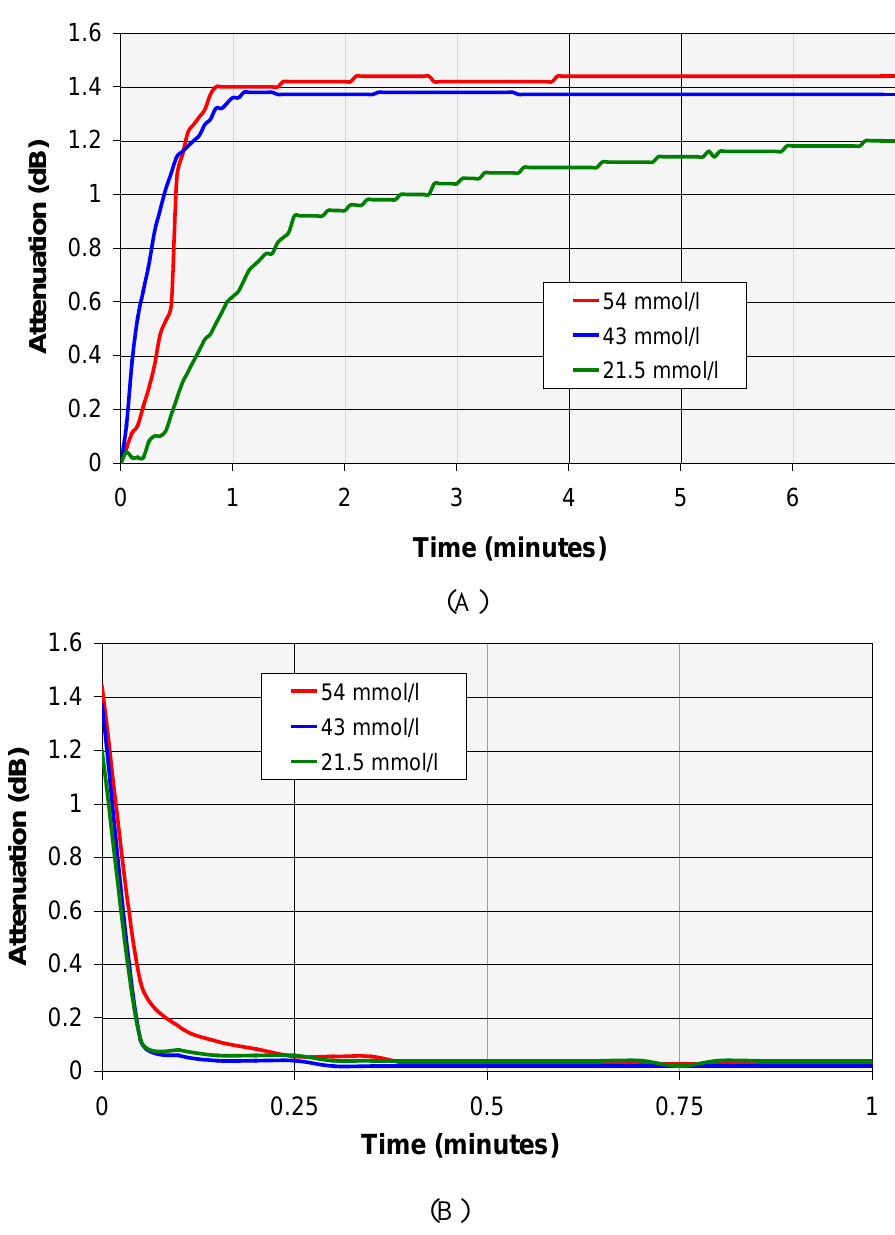
Figure 8. (a) Detail of the rise and stabilization of the optical reflected power when the response of the sensor when exposed to different ethanol concentrations. (b) Detail of the fall response of the sensor when the chamber is opened showing the recovery of the initial power